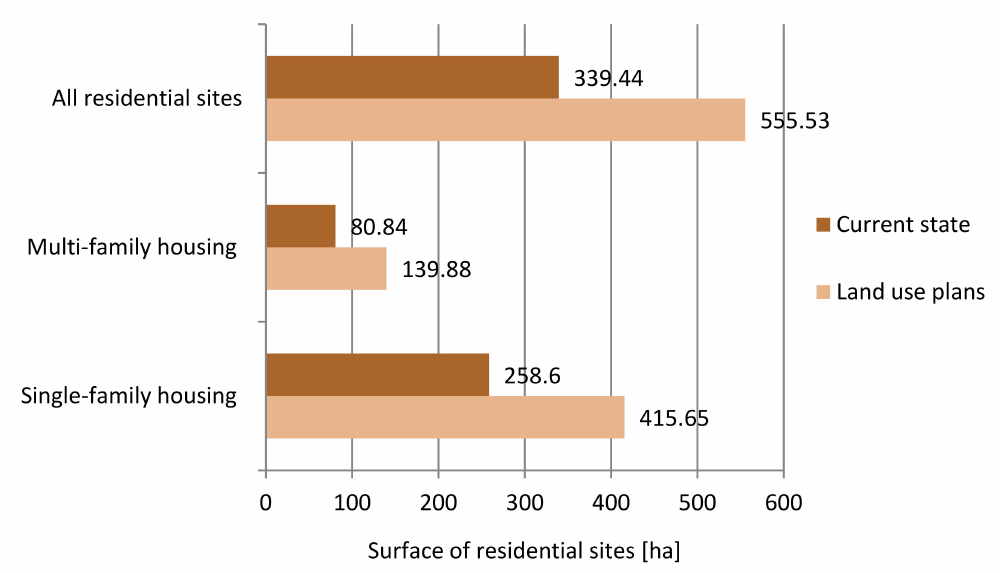
Figure 10. Changes in the area of residential development: current state and land use plans.